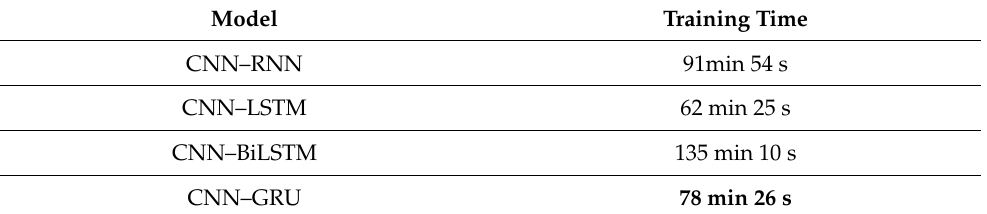
Table 4. Computational cost of different DL and hybrid DL algorithms. Model Table 4. Cont.